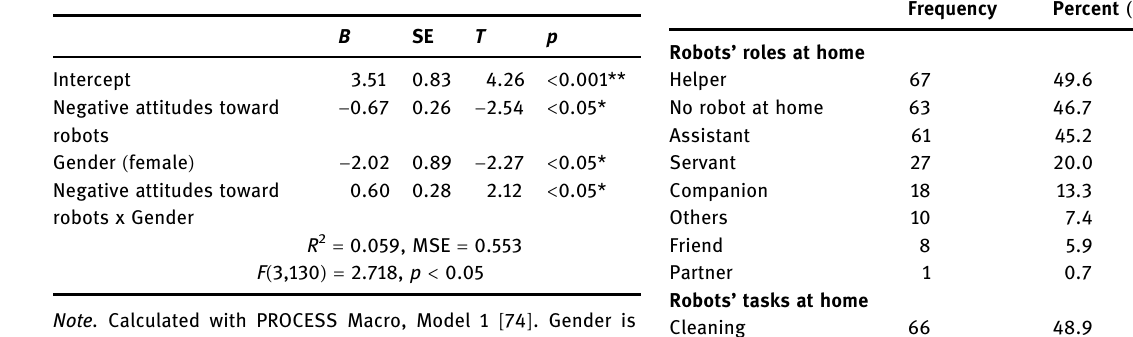
Table 9: Gender as moderator of the relationship between Negative attitudes toward robots and Wish to have a robot as a partner B SE T p Intercept